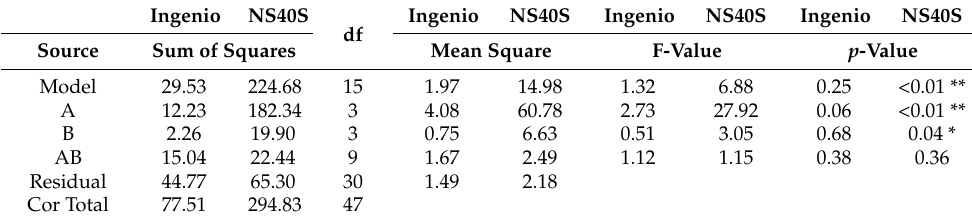
Table 8. ANOVA table for biomass in